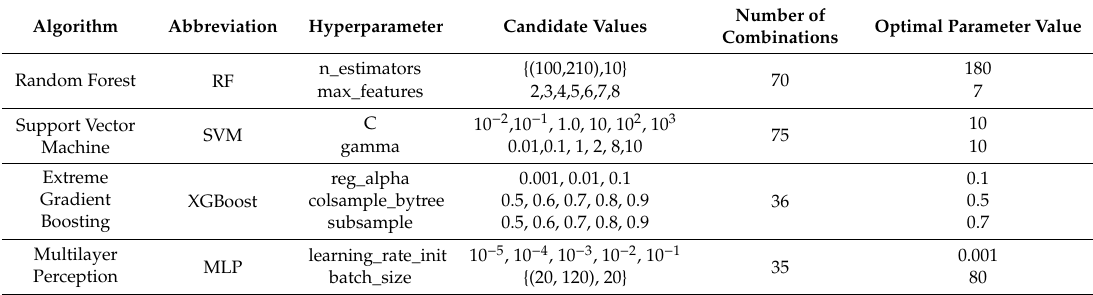
Table 2. Parameters of non-CNN classifiers.